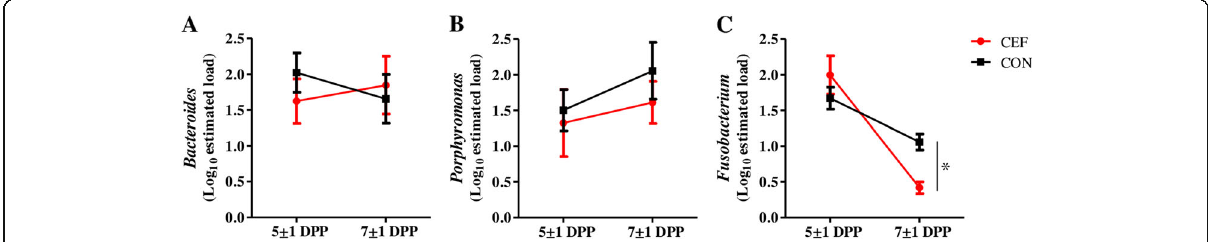
Fig. 3 Estimated load for uterine pathogens. a Bacteroides. b Porphyromonas. c Fusobacterium . Bacterial loads were compared between groups at each time point using one-way ANOVA ( P ≤ 0.05*). Data represent mean and